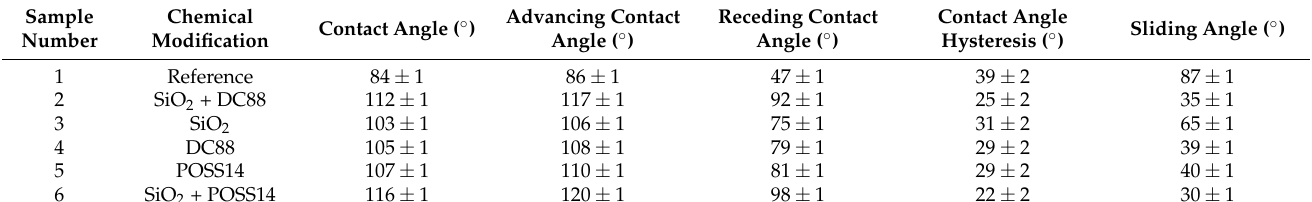
Table 3. Wettability parameters of the samples.